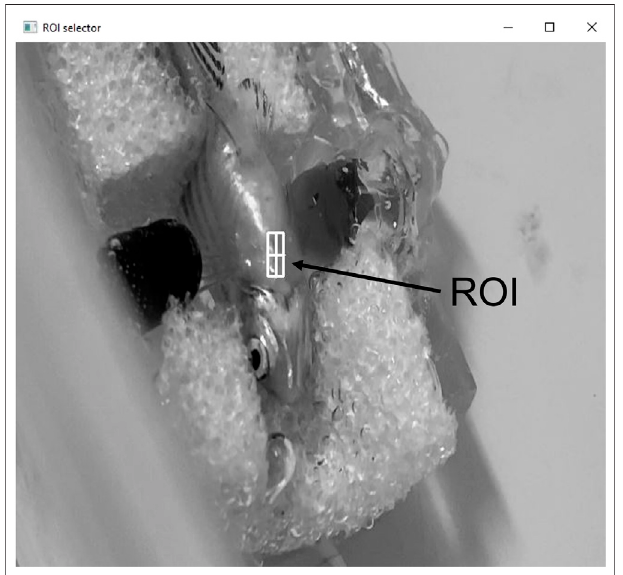
FIGURE 8 | Interface of the computer vision software and ROI selection.